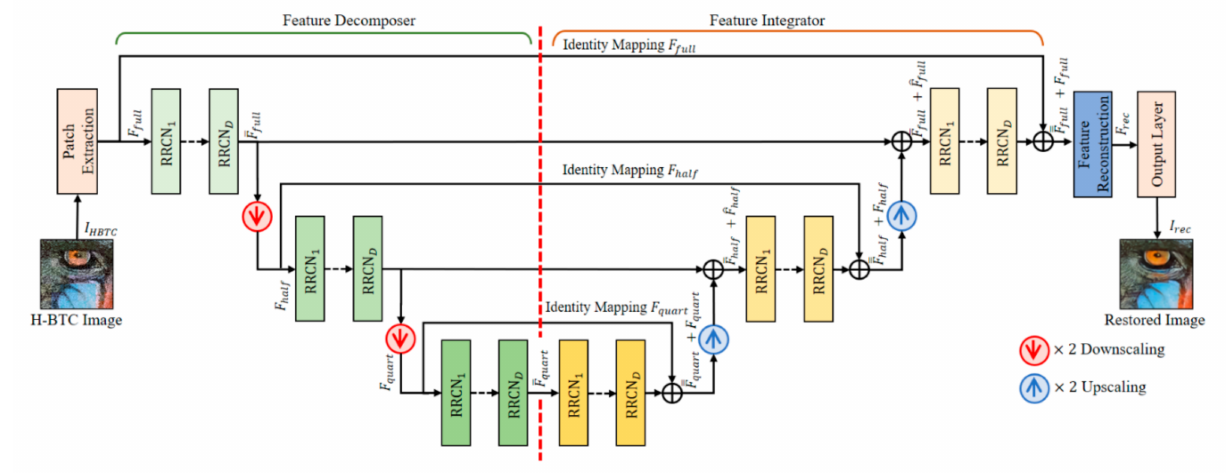
Figure 8. The proposed networks architecture for H-BTC image